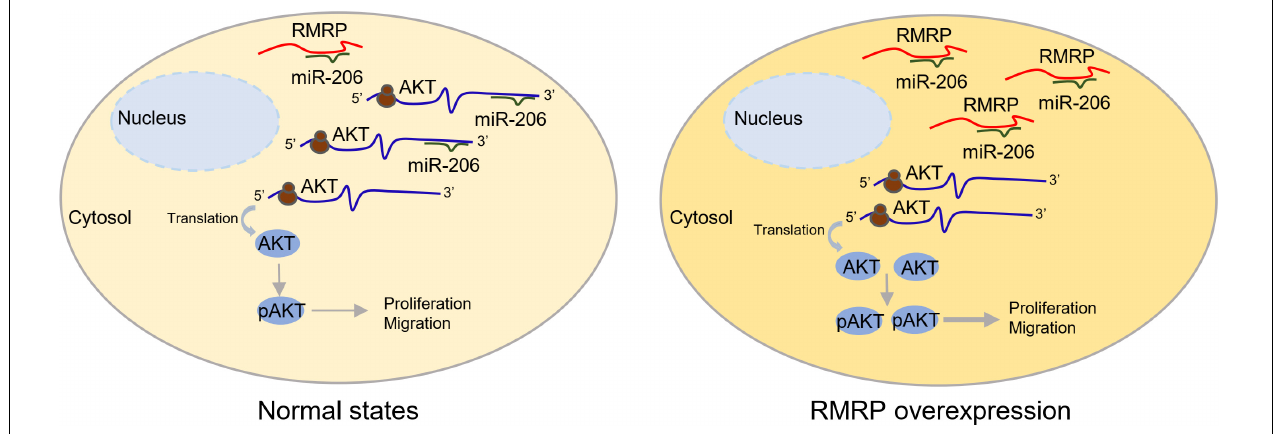
FIGURE 7 | A schematic for RMRP induces AKT expression by inhibiting miR-206 in breast cancer. Under the physiological condition, miR-206 targets AKT mRNA for rapid turnover or translational inhibition, leading to reduced cell proliferation and migration (left panel). In the context of RMRP overexpression, RMRP sequesters miR-206 to unleash AKT activity, leading to enhanced breast cancer cell proliferation and migration (right